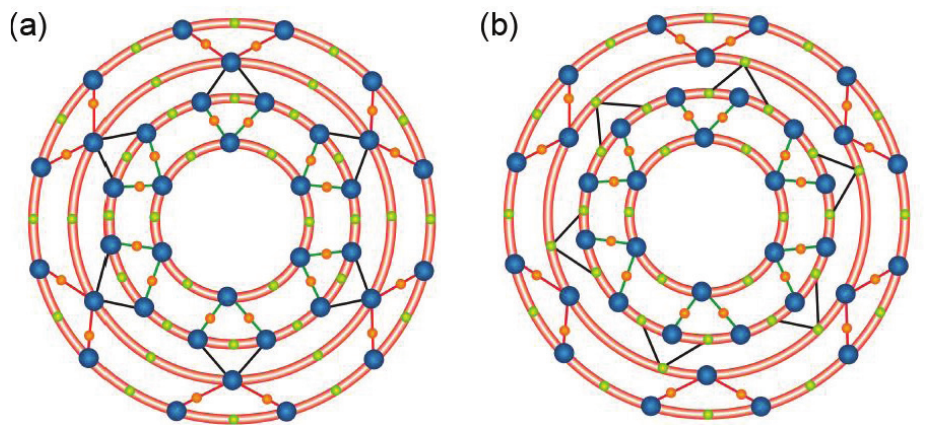
Figure 2: (a) First metal-organic framework (MOF1 (t) for t = 2); (b) Second metal-organic framework (MOF2 (t) for t =